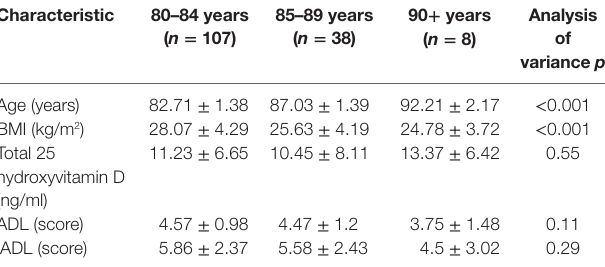
Table 2 | Characteristics of study population in age groups (mean ± SD).